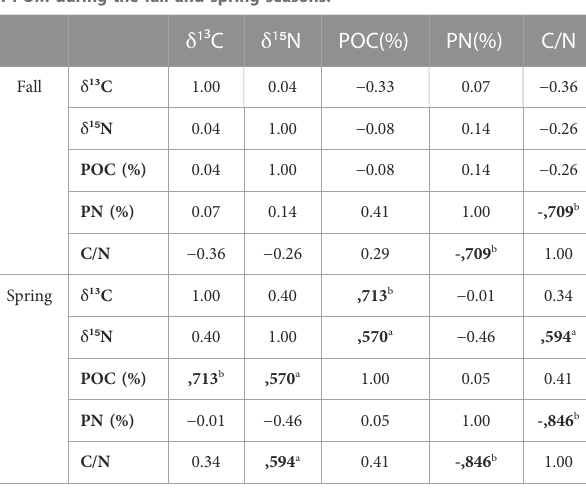
TABLE 3 Pearson correlation between the elemental and isotopic composition of POM during the fall and spring seasons.